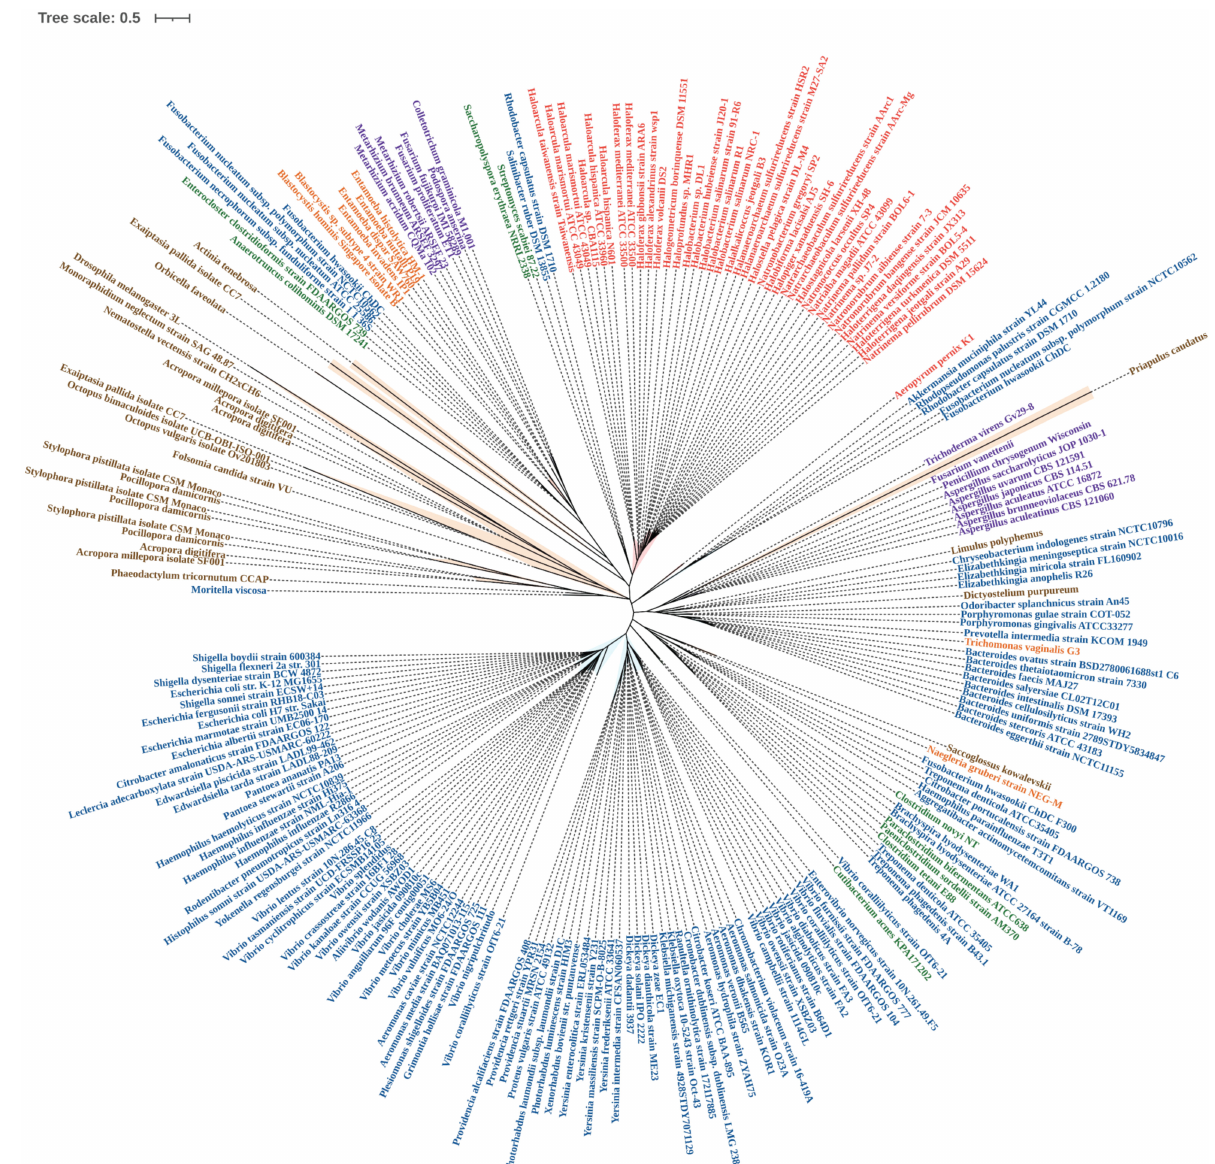
Figure 1. Nucleotide sequence phylogenetic tree (arbitrarily rooted Maximum Likelihood tree) of the tnaA gene representing a total of 221 nucleotide sequences belonging to 95 genera of various taxonomic groups. All the nodes represent bootstrap values ≥ 70 (1000 replications) and bootstrap value representation in Figure S1. Details of the phylogenetic analysis are provided in Methods. A complete list of genera and species and their taxonomic classifications are provided in Table 1. Species names are labelled according to phylogenetic classifications by the following colour codes. Gram-negative bacteria (blue), Gram-positive bacteria (green), archaea (red), fungi (purple), unicellular eukaryotes (orange), higher eukaryotes